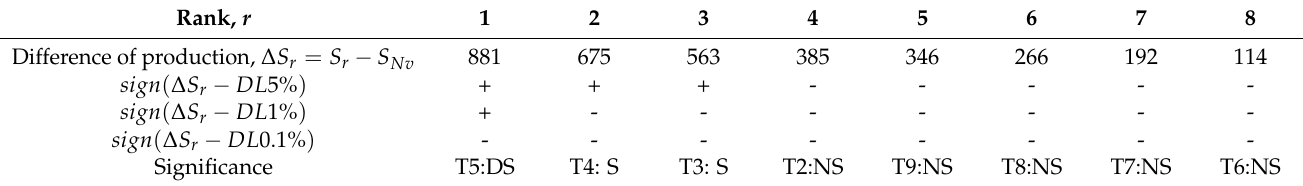
Table 7. Centralization of the data necessary for the classification of variants by the limit difference (DL) test. Rank, r 1